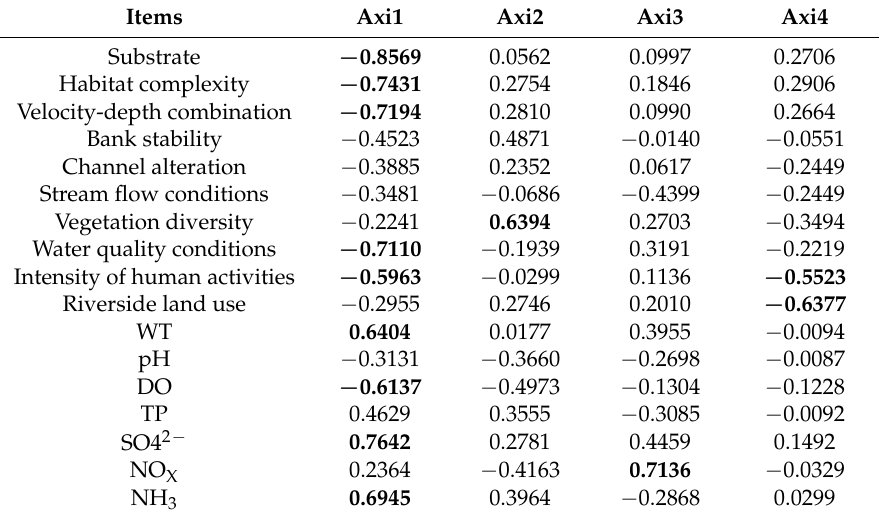
Table 1. Eigenvector matrix for principal component analysis (bold values are considered high ≥ |0.5|). WT: water temperature; DO: dissolved oxygen; TP: total phosphorus.